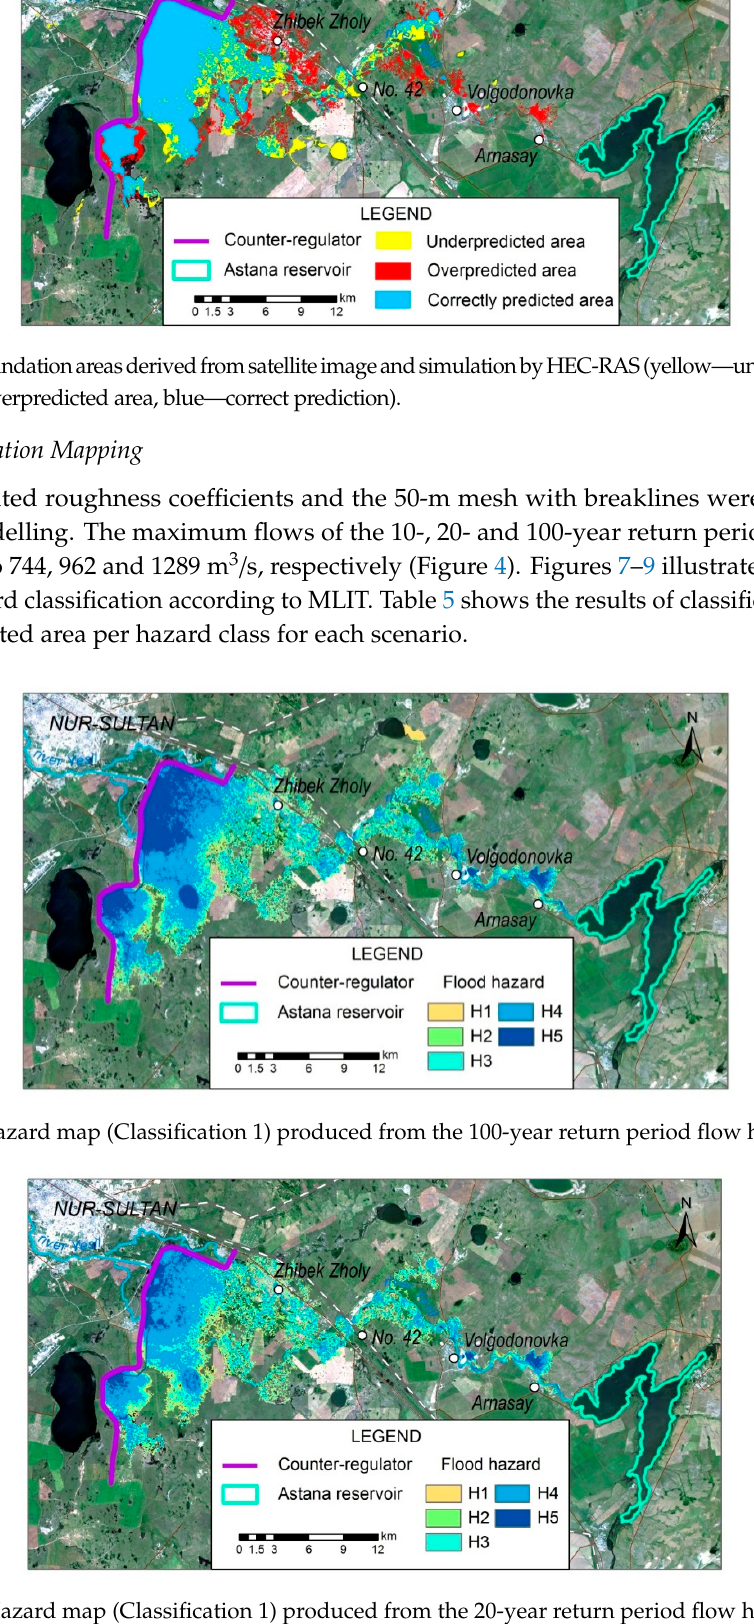
Figure 9. Hazard map (Classification 1) produced from the 10-year return period flow hydrograph. Table 5. Results of flood hazard classification (Classification 1) for each scenario. Hazard Classification